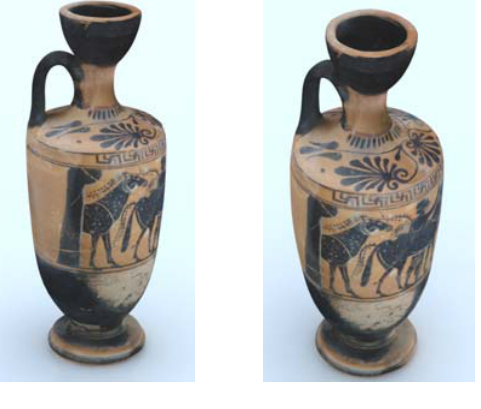
Fig. 9. The final texture map of the smaller lekythos